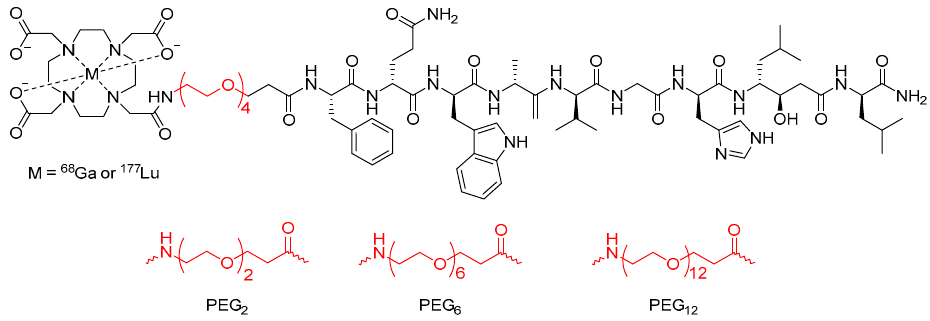
and [ 18 F]FB-mini-PEG-E[c(RGDyK)] 18 F]FB-mini-PEG-E[c(RGDyK)] 2 2 and [